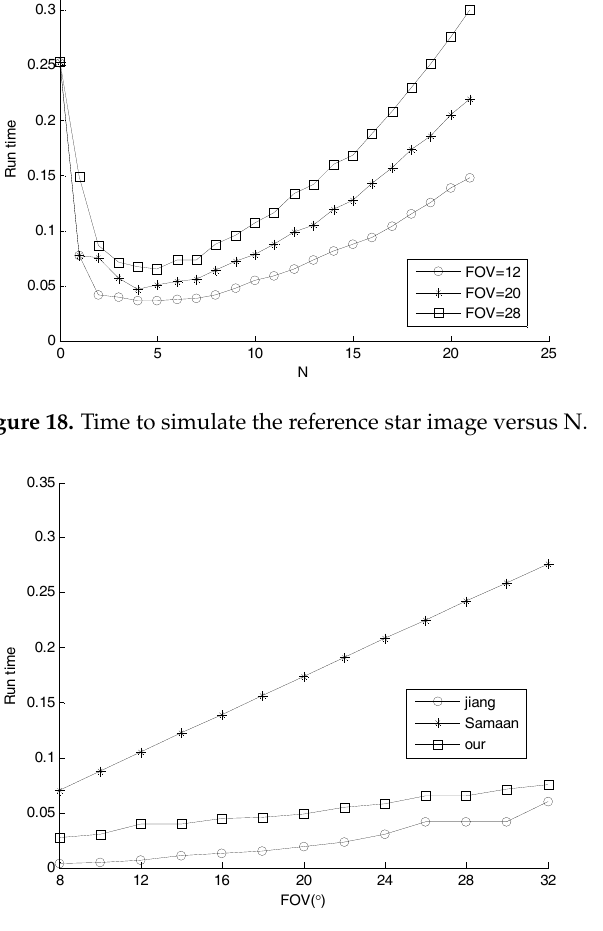
Figure 19. Time to simulate the reference star image versus FOV.